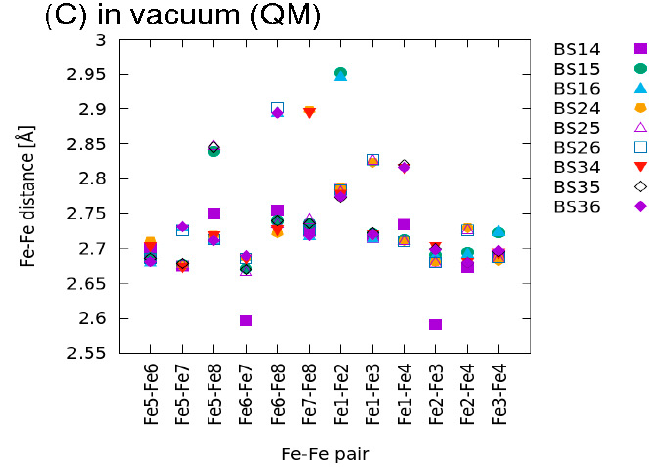
Figure 7. The distance between Fe atoms (Å) in the DCC ( A ) is compared for protein environment ( B ) and vacuum ( C ). Fe ‐ Fe distances span a larger range in the absence of the protein scaffold. ( B ) and vacuum ( C ). Fe-Fe distances span a larger range in the absence of the protein scaffold. Figure drawn using gnuplot and TGIF. Figure drawn using gnuplot and TGIF.